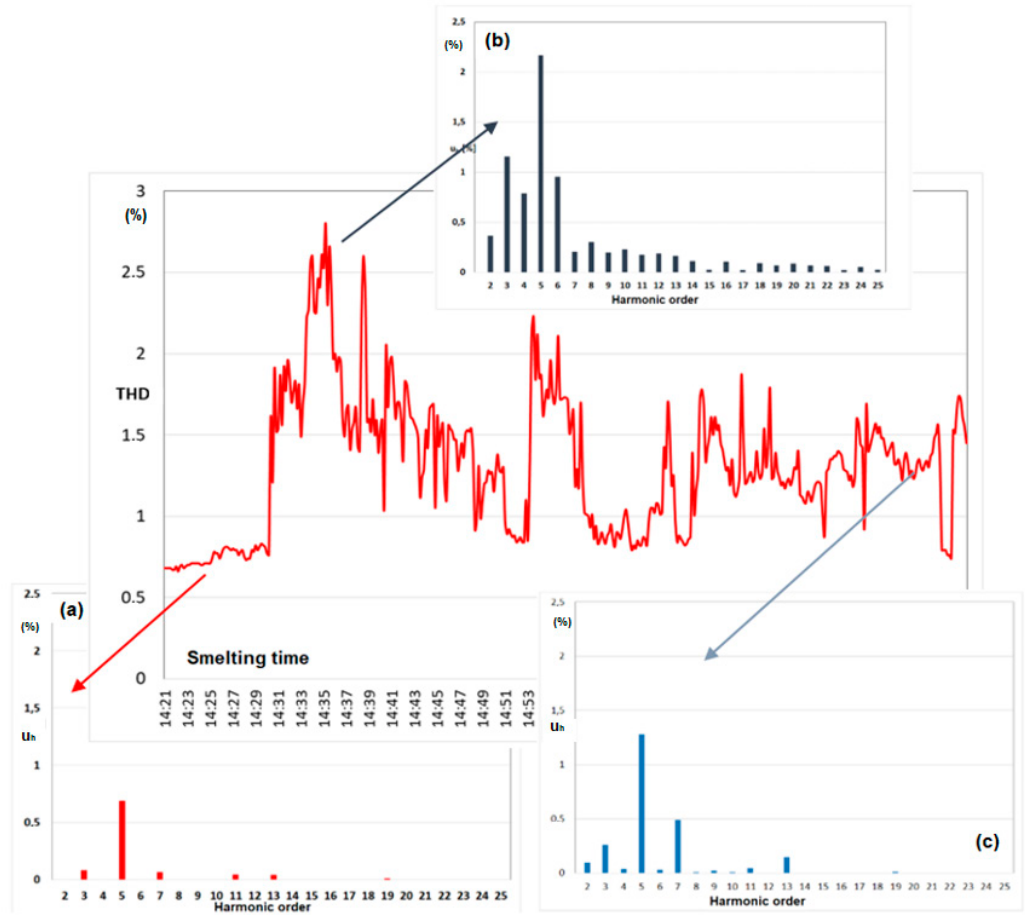
Figure 19. Changes in THD coefficient and voltage harmonic spectra in different stages of casting: ( a ) furnace off; ( b ) beginning of melting the charge; ( c ) molten charge.